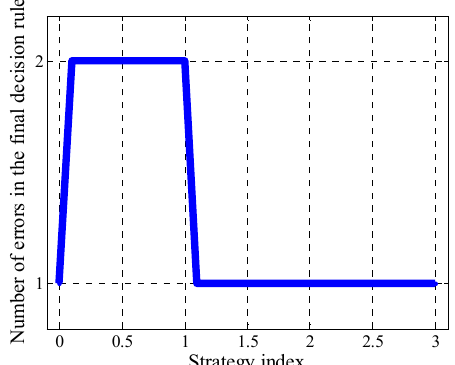
Figure 6. Dependence of the number of the final GDRC on the assessment strategy.